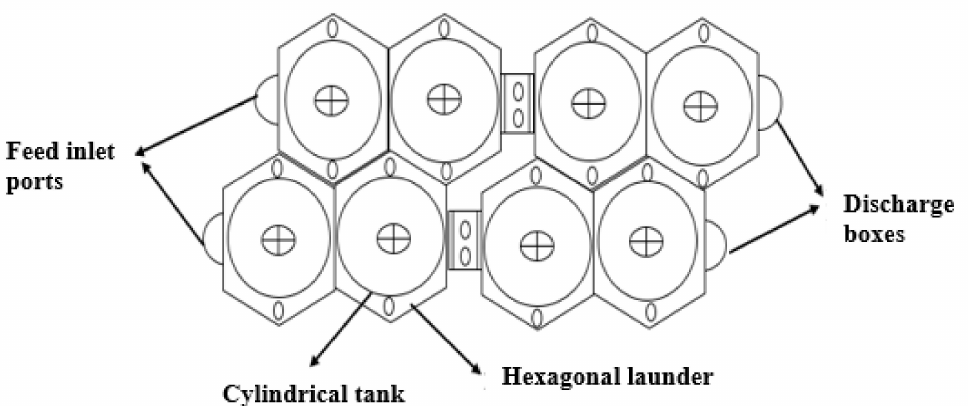
Figure 7. Honeycomb arrangement for a bank of cells